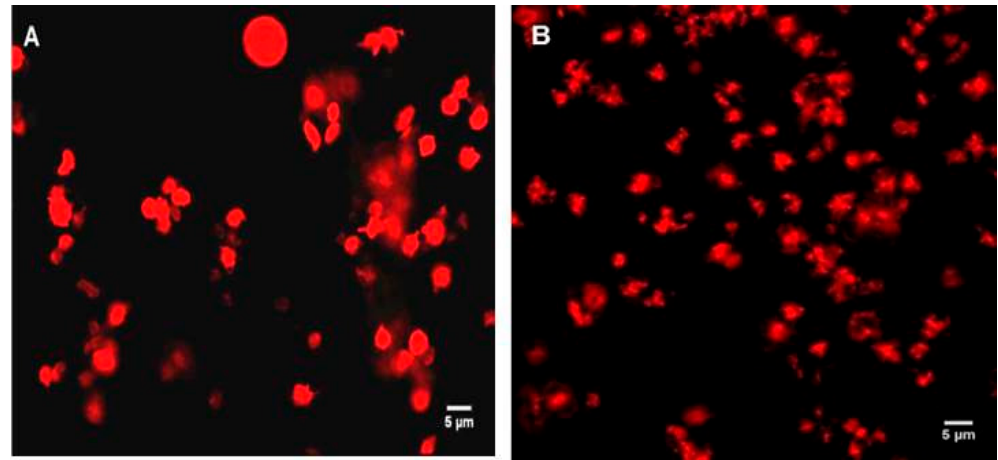
Figure 4. Representative confocal microscopy images. ( A ) Resting platelets in PRP; ( B ) ADP ‐ induced platelets in PRP. Platelets in PRP were fluorescently labelled with phalloidin ‐ TRITC at 0.25 mg/mL and fixed using 1% formaldehyde. Magnification 100×. Scale bar represents 5 μ m.